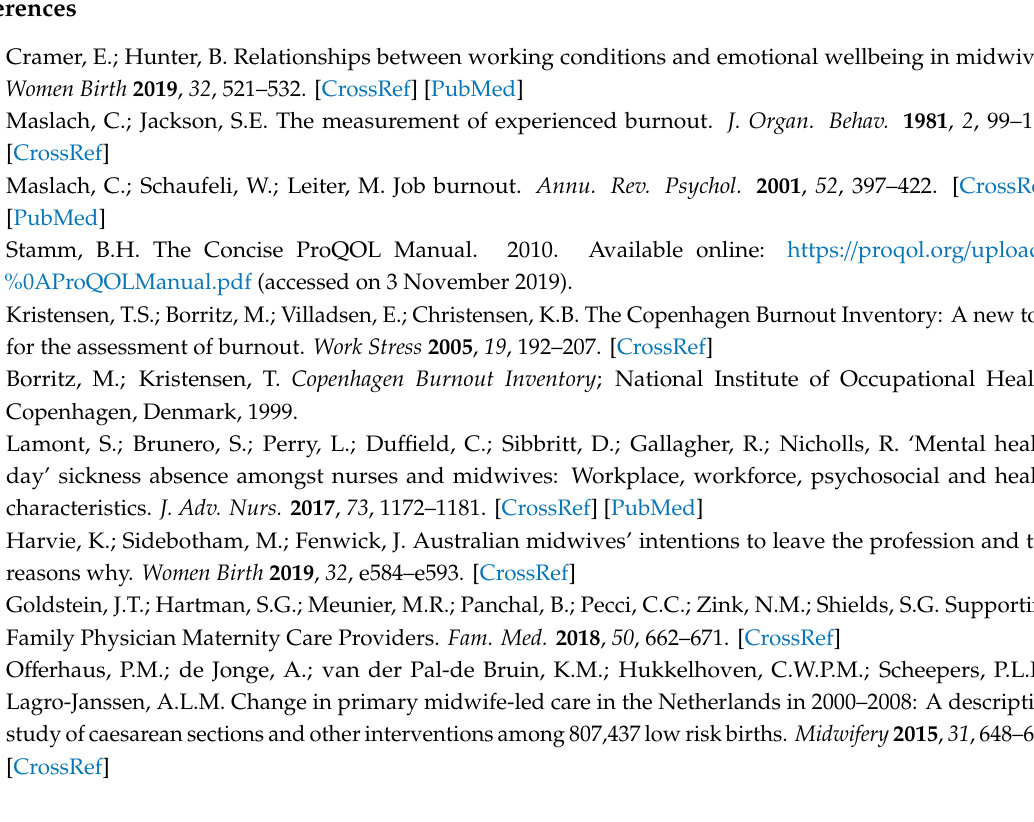
Table S1: PRISMA